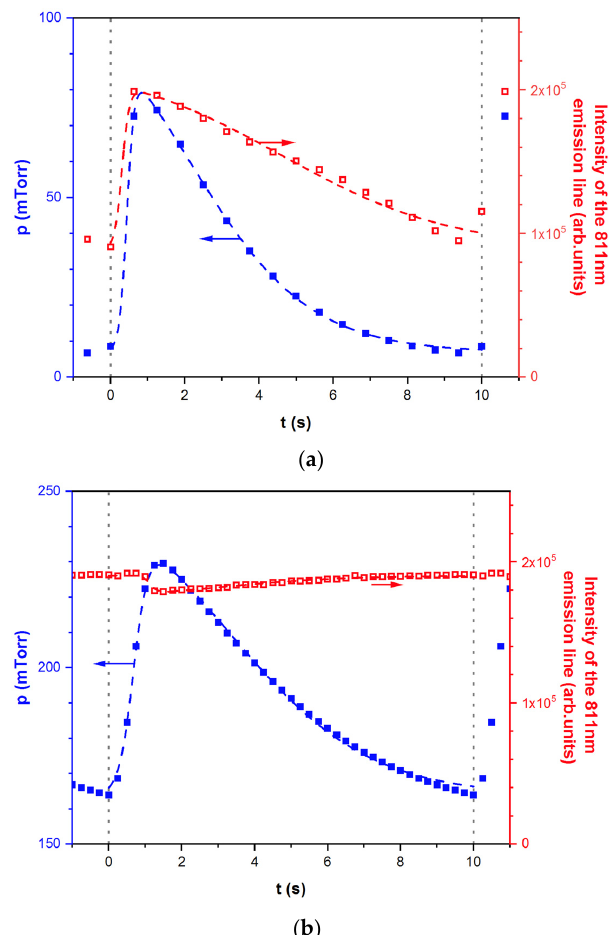
Figure 3. Comparison between the evolutions of the pressure (blue curve) and the Ar 811 nm emission line intensity (red curve) on an injection period. Injection frequency is set to 0.1 Hz corre- sponding to an overpressure Δ p ~70 mTorr. In ( a ), the base pressure is set at p 0 ~5 mTorr and in ( b ) at p 0 ~160